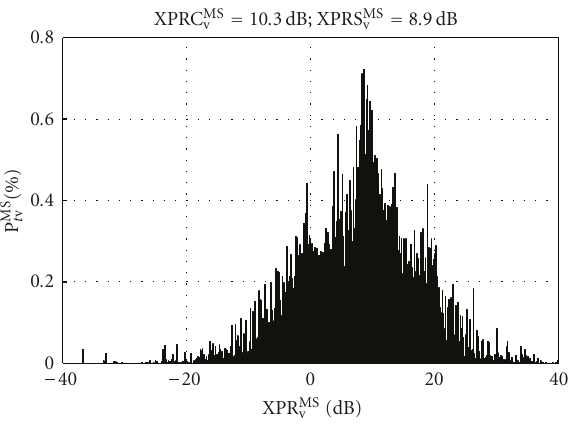
dependent on the t v